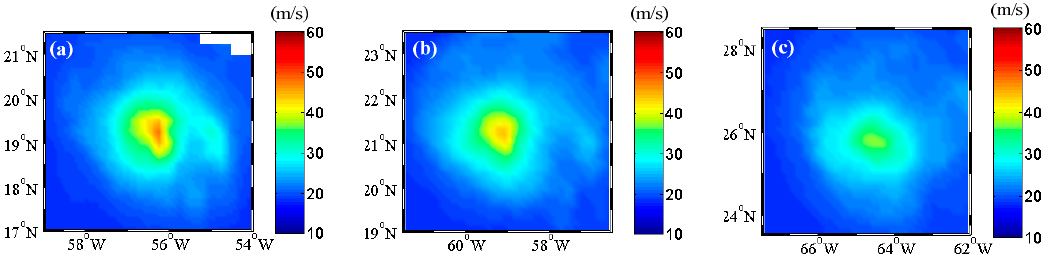
Figure 12. Retrieved wind speeds using the AMSR-E 6 and 10 GHz h-pol and v-pol brightness temperature data over hurricane Bill on ( a ) 19 August 2009, at 1650 to 1654 UTC; ( b ) 20 August 2009, at 0512 to 0516 UTC; and ( c ) 21 August 2009, at 0555 to 0559 UTC.